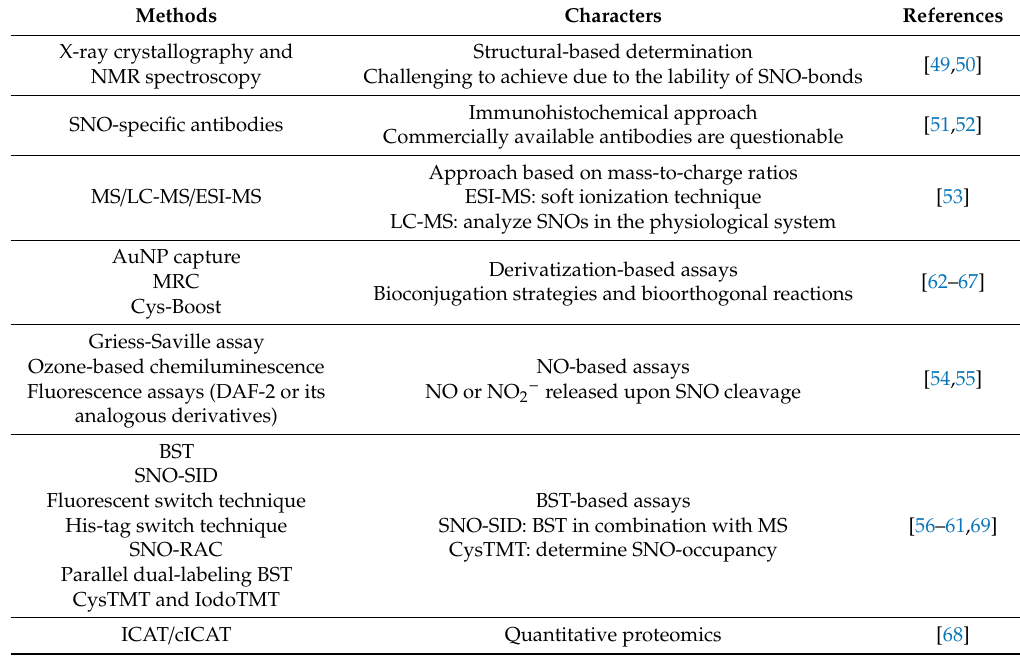
Table 1. Summarization of methods for detection, identification, and quantitation of SNO.